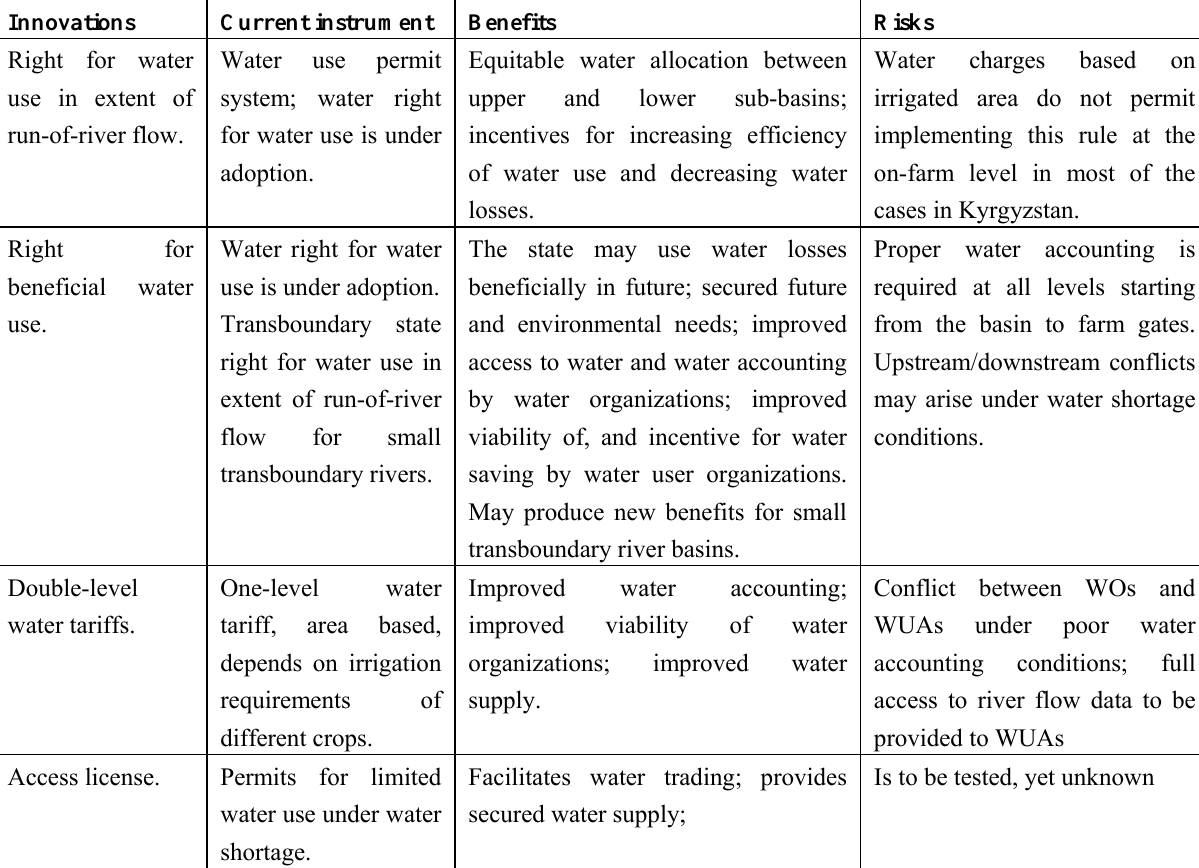
Table 5. Implications of adopting innovations suggested by two case studies to water allocation in